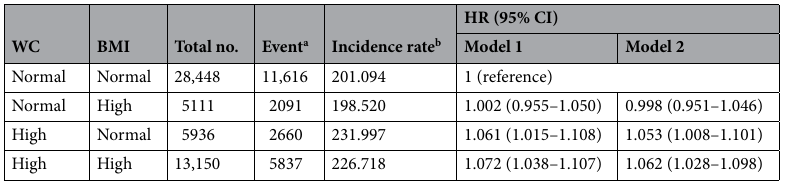
Table 2. Subgroup analysis of on the longer duration of CSU. BMI body mass index, CI confidence interval, CSU chronic spontaneous urticarial, HR hazard ratio, WC waist circumference. High WC was defined as ≥ 90 cm in males or ≥ 85 cm in females, and high BMI was defined as ≥ 25 kg/m 2 . a Event; disease duration over 3 years, b per 1000 person-years. Data were expressed as HR and 95% CI. Model 1 was adjusted for age and gender. Model 2 was adjusted for age, gender, comorbidities of diabetes mellitus, hypertension, and